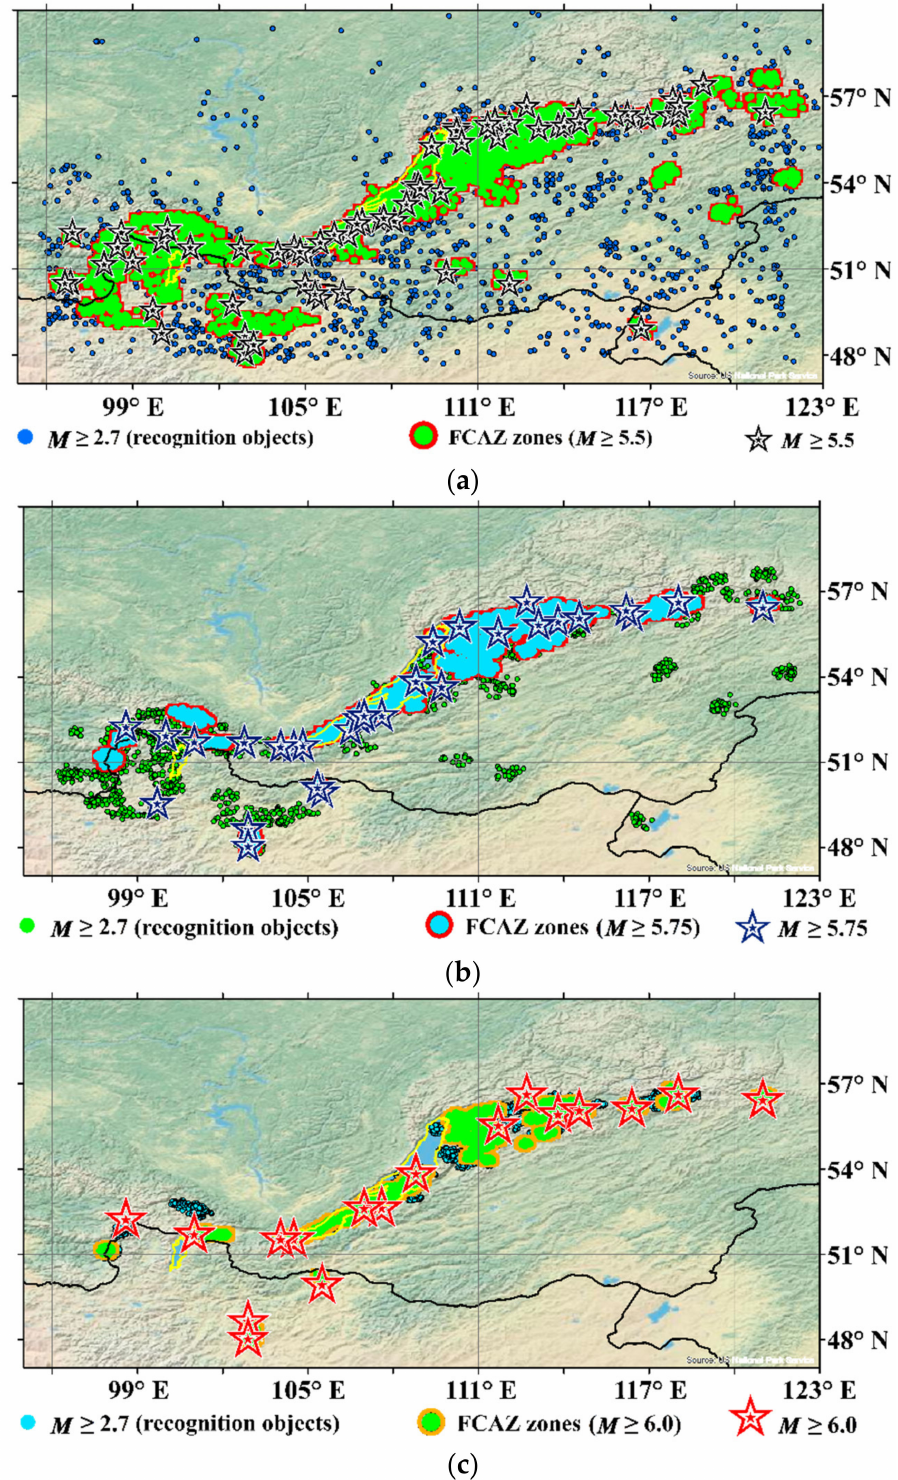
Figure 10. Baikal–Transbaikal region: ( a ) zones prone to earthquakes with M ≥ 5.5 and the epicenters of earthquakes with M ≥ 5.5; ( b ) zones prone to earthquakes with M ≥ 5.75 and the epicenters of earthquakes with M ≥ 5.75; ( c ) zones prone to earthquakes with M ≥ 6.0 and the epicenters of earthquakes with M ≥